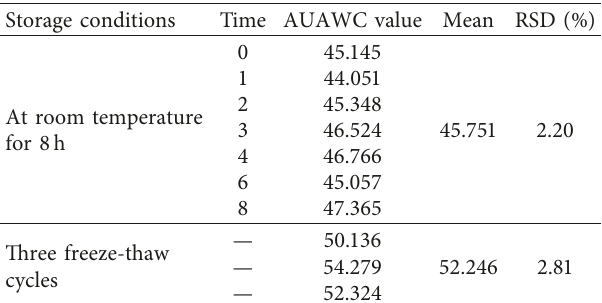
Table 3: Stability of plasma samples under different storage conditions ( n 6). (cid:31)